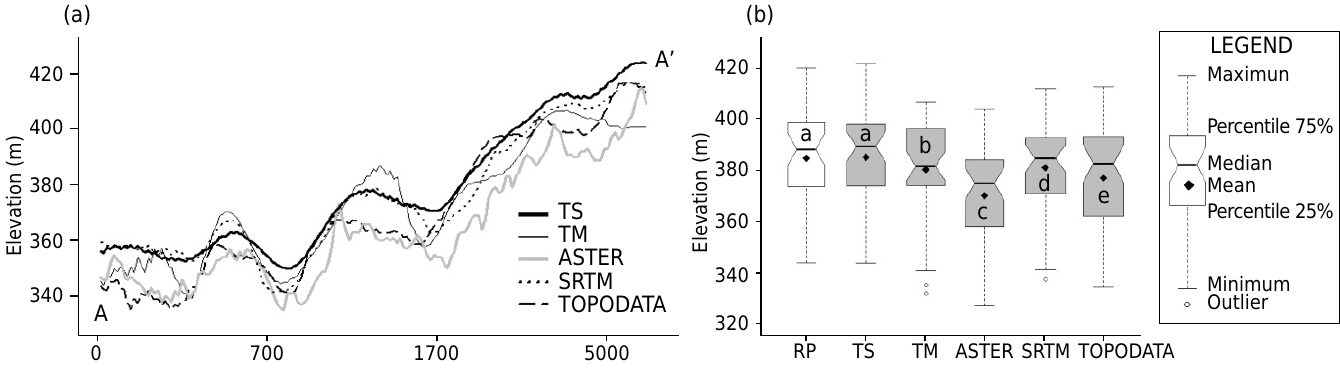
Figure 3. (a) Topographic profile produced from the transect A-A’ of the five DEMs; (b) boxplots with the result of the Student’s t test (significance level α = 0.05) for the altitude values of reference points (RP) and the five DEMs.